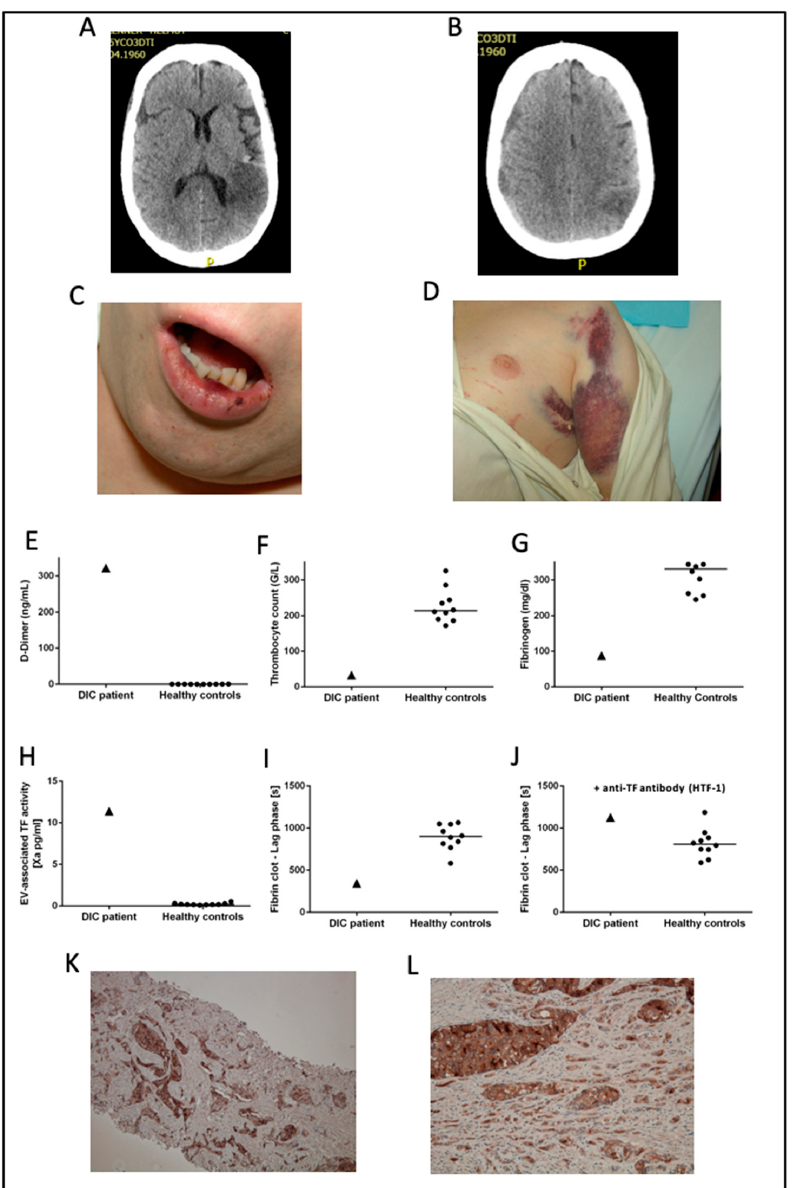
Figure 2. A case of a prostate cancer patient with overt DIC included in the present study. In ( A , B ) cerebral computed tomography scans of the patient are shown. Mucosal oozing and disseminated subcutaneous hematomas are shown in ( C , D ). In ( E – J ), each triangle represents a single measurement of the DIC patient, each dot represents a single measurement of a healthy control subject, and lines represent the median in healthy controls. In ( K ), immunohistochemical staining for TF in a prostate punch biopsy obtained at diagnosis is shown. In ( L ), staining for TF in the prostate obtained post mortem is shown. Abbreviations: ISTH—International Society on Thrombosis and Haemostasis; EV—extracellular vesicle. ( K ): ×100, ( L ): ×400.